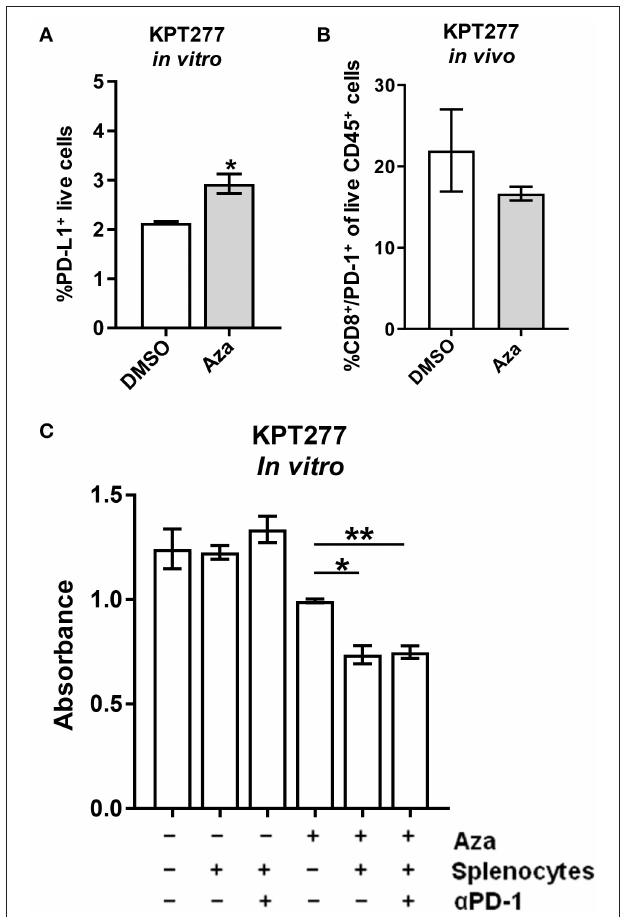
FIGURE 4 | Aza treatment potentiates splenocyte killing of KPT277 cells that is not enhanced by PD-1 checkpoint blockade. (A) KPT277 cells were treated with Aza at 20 µ M in vitro for 96h and analyzed by flow cytometry using a fluorescent, fixable viability dye and an antibody recognizing PD-L1. Bars represent living, %PD-L1 positive cells out of total cells. n = 3 biological replicates. (B) KPT277 cells pre-treated for 72h with DMSO or Aza (20 µ M) were implanted in mice subcutaneously for 48h. Tumors were then removed, digested, and analyzed by flow cytometry for PD-1, CD-8, and CD45 expression as well as live/dead cells using a fixable viability dye. Bars represent the percent of PD-1 + /CD8 + cells out of live, CD45 + cells. N = 2 tumors per group. (C) KPT277 cells treated with DMSO or 20 µ M Aza (72h) were incubated with or without splenocytes (100:1) from an Aza pre-treated (10 µ M for 96h), KPT277 tumor-burdened mouse. Splenocytes pre-treated with anti-PD-1 antibody (2.5 µ g/mL) in vitro for 1h are indicated. KPT277 cell viability after 24h of co-incubation was assayed by MTT. Bars represent absorbance values at 595nm. n = 3 biological replicates. Error bars